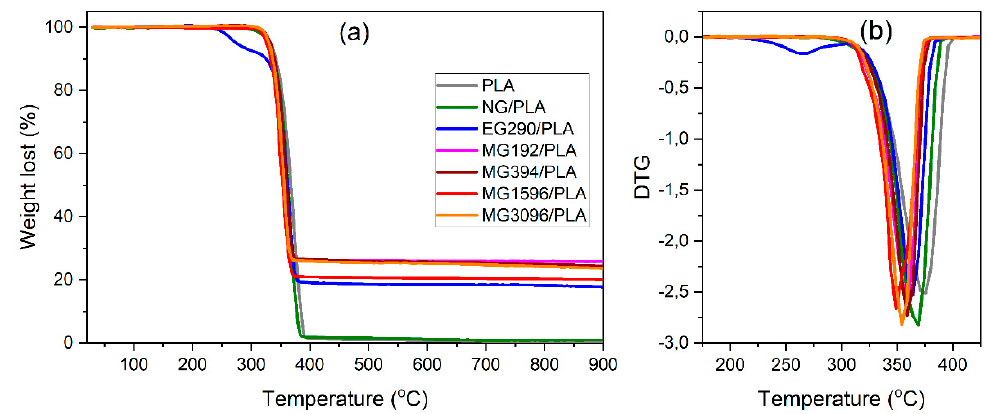
Figure 3. Thermogravimetric curves of graphite/PLA composites: ( a ) TG plots ( b ) DTG plots. Table 2. Thermal parameters obtained from TG and DTG curves of graphite/PLA